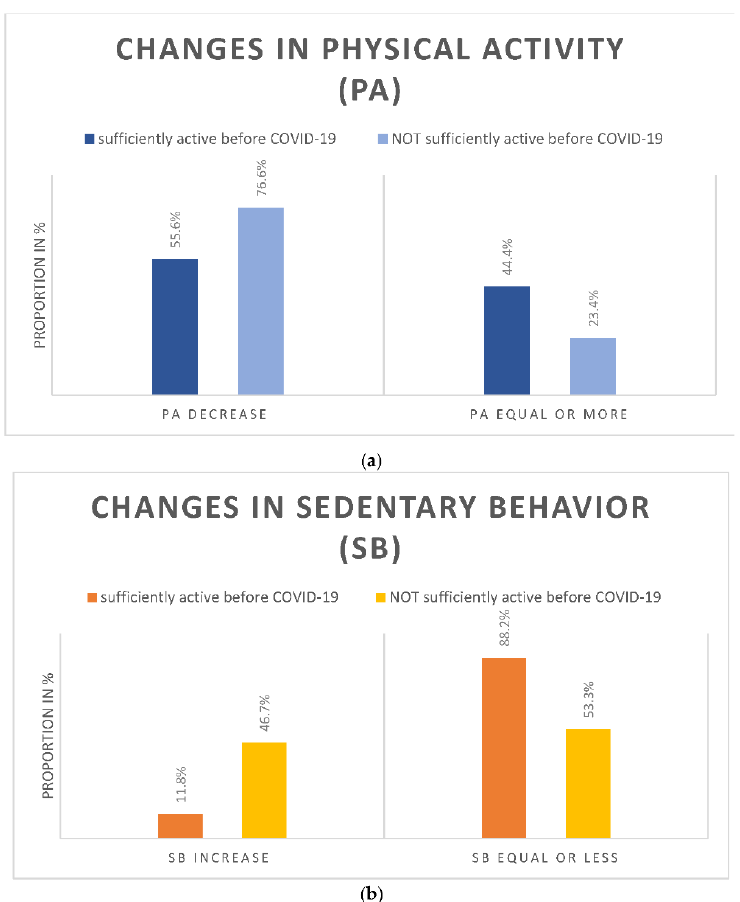
Figure 3. The proportion of participants reporting ( a ) changes in PA (PA decrease: decrease in any of the 5 PA settings); ( b ) changes in SB. Changes are stratified for having fulfilled WHO recommen- dations regarding PA before COVID-19.